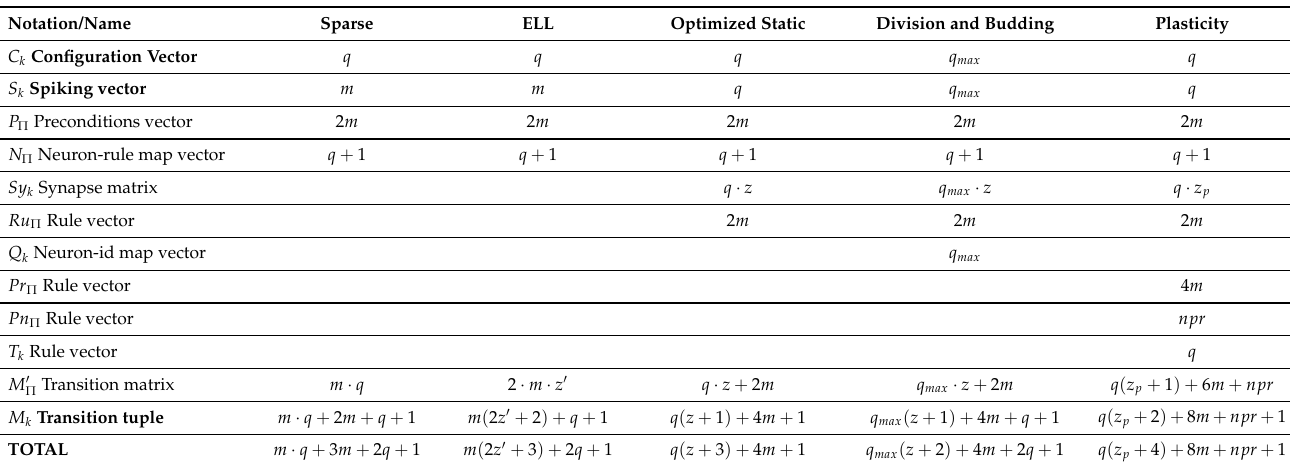
Table 2. Size of matrices employed in the representations for SNP systems. Those whose name are in bold were used for the total calculation, which assumes just one spiking vector.